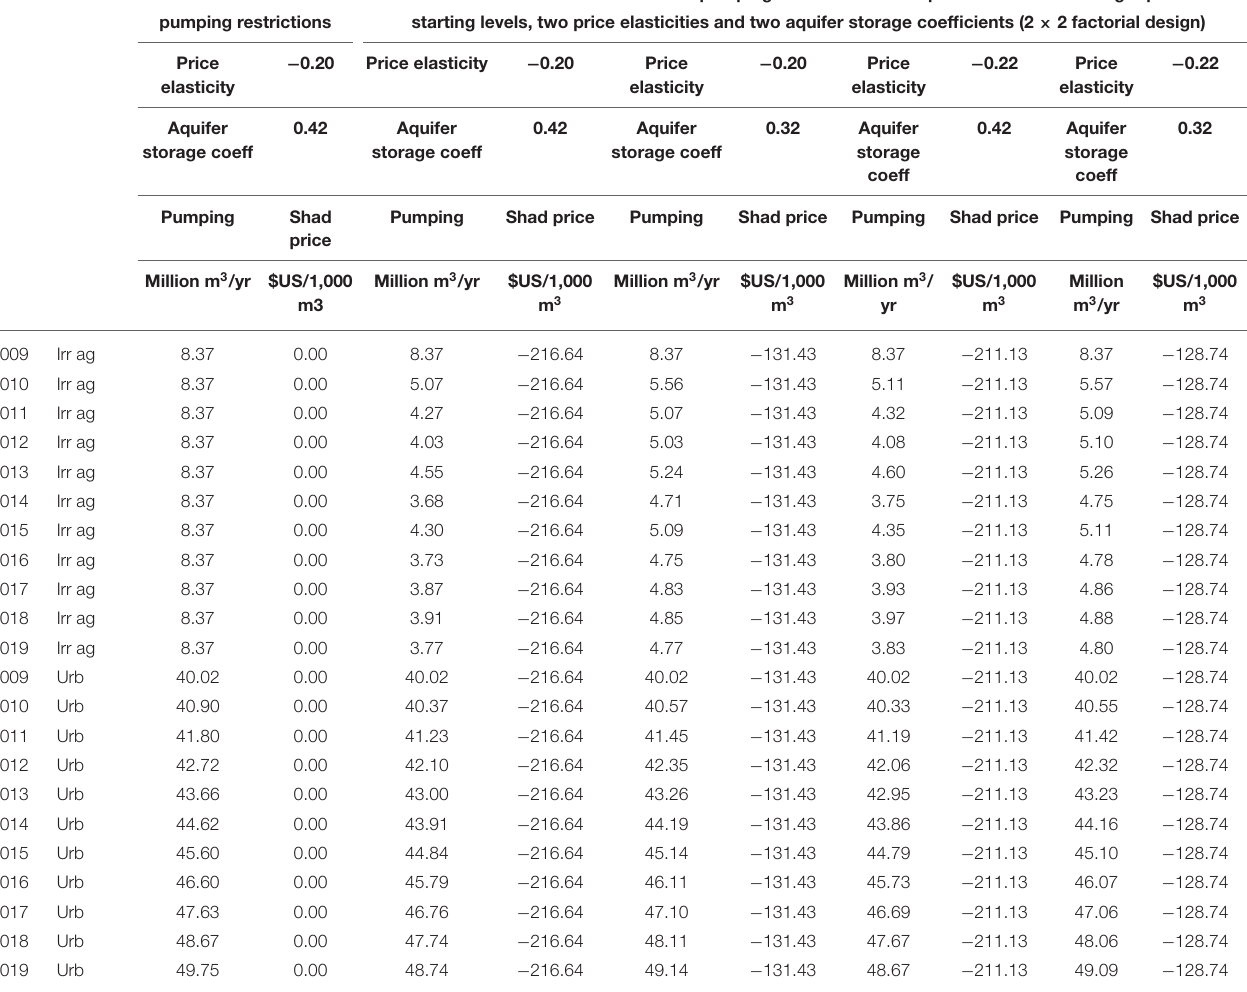
TABLE 6 | Hydroeconomic model results illustration—water use and marginal value of additional water (shadow price) pumped by sector, urban price elasticity of demand, and aquifer storage coefficient, Nairobi Aquifer, Kenya, 2009–2019. Year